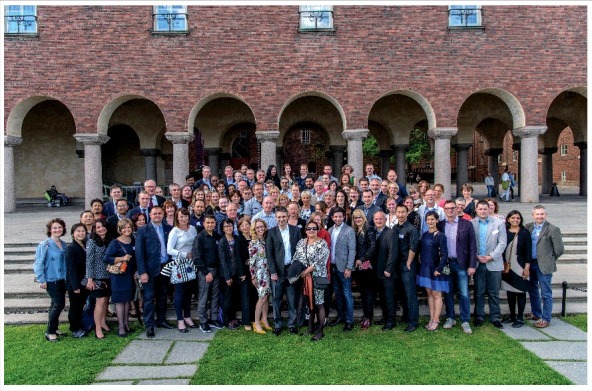
Group photograph of the 12th EOMW participants in front of the Stockholm City Hall during the social event, on 26th May 2017 (credit: Jack Mikrut).